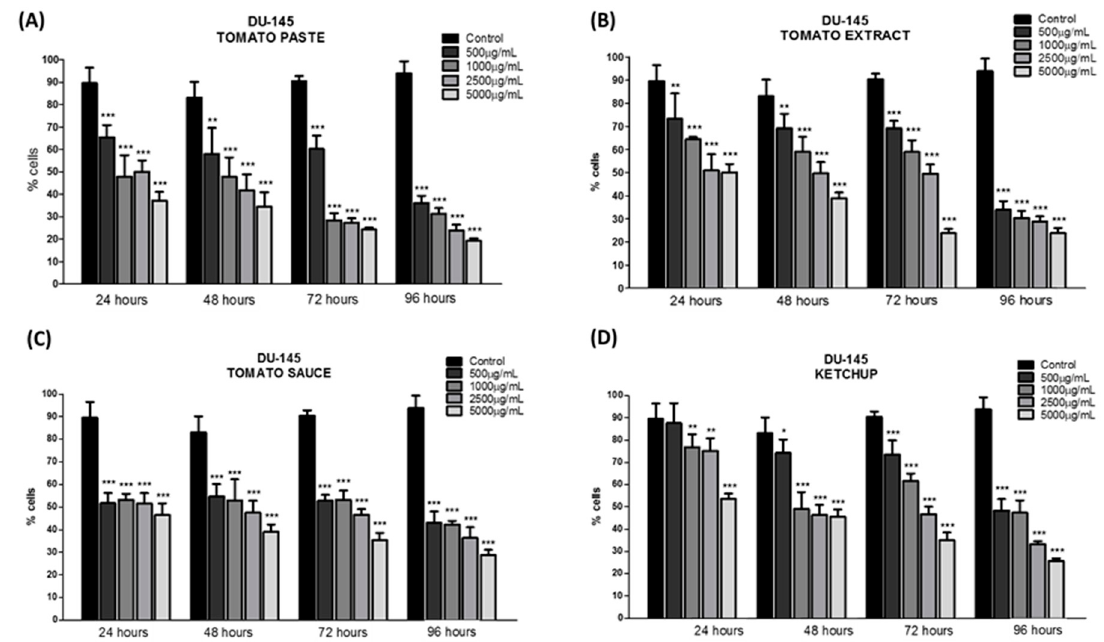
Figure 1. Effect of lycopene obtained of tomato paste ( A ), tomato extract ( B ), tomato sauce ( C ), and ketchup ( D ) on DU-145 cell viability after 24, 48, 72, and 96 h of exposure, respectively. The results are expressed as mean ± error standard and significant differences between untreated cells (Control) and those treated with lycopene (500, 1000, 2500, and 5000 μ g/mL) were compared by one-way ANOVA followed by Tukey’s multiple comparison post-hoc test. * p < 0.05; ** p < 0.01; *** p < 0.001.